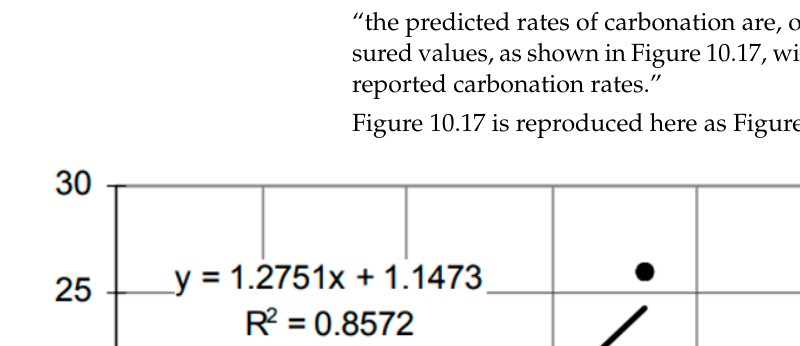
Figure 10.17 is reproduced here as Figure 3.